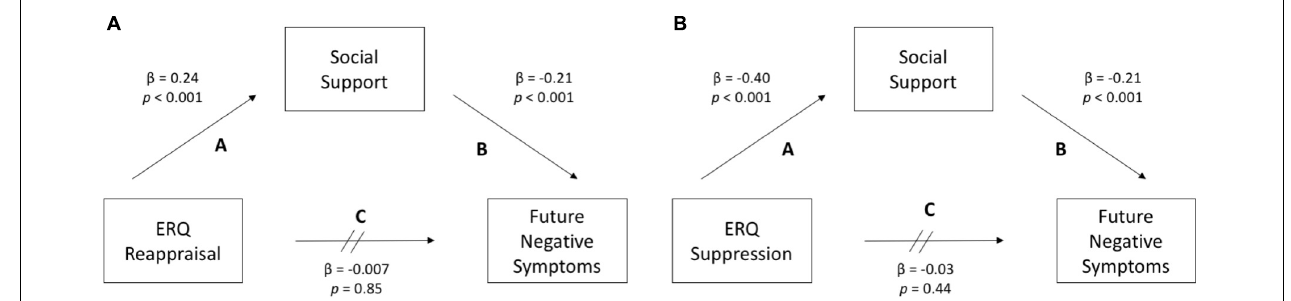
FIGURE 1 | (A) The habitual use of cognitive reappraisal does not significantly predict future symptoms of depression and anxiety (Path C). Instead, it is significantly associated with perceived social support (Path A), which in turn significantly predicts future symptoms (Path B). (B) The habitual use of expressive suppression also does not predict future negative symptoms (Path C), but is negatively associated with perceived social support (Path A), which in turn predicts future symptoms (Path